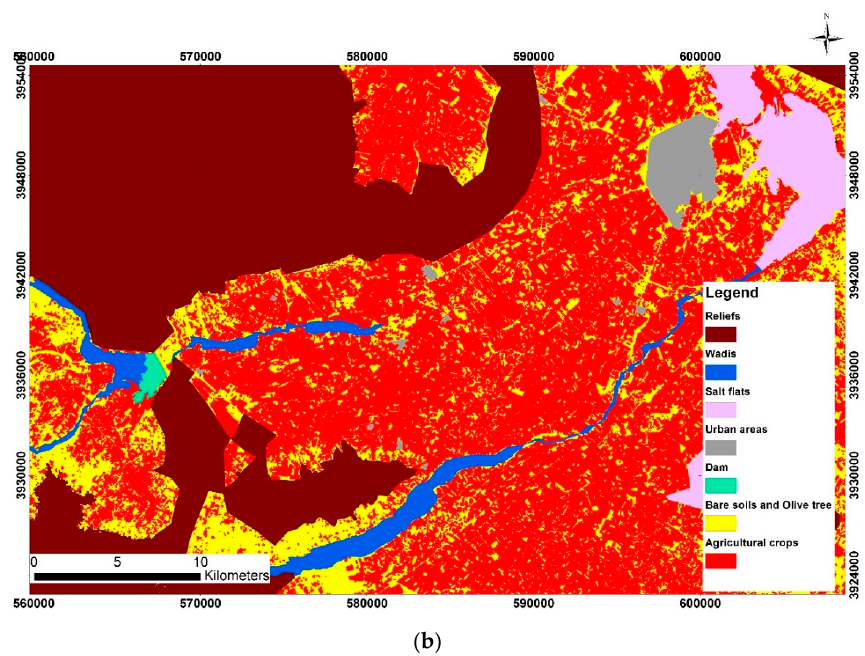
Figure 1. ( a ) Location of the study site; ( b ) land use map.